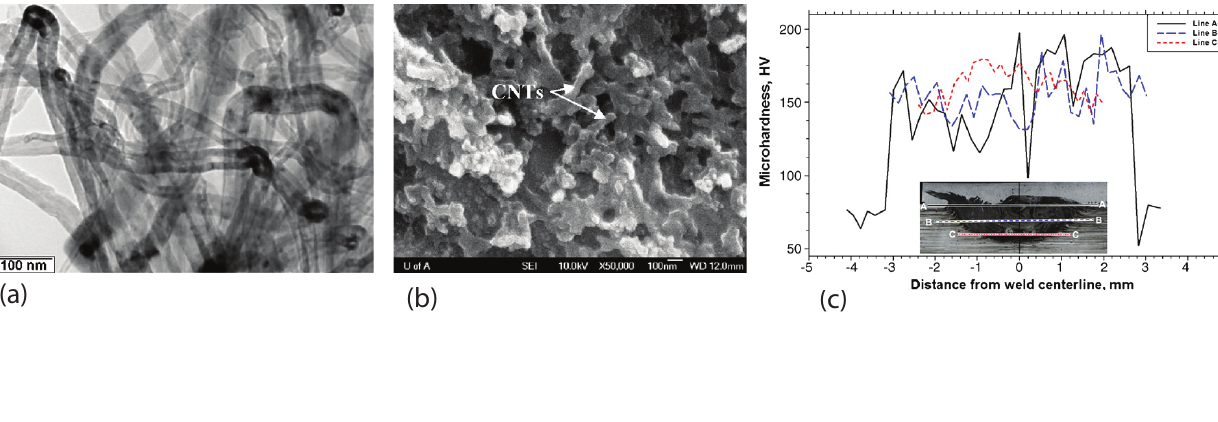
Figure 9 . Backscattered electron images showing friction stir processed in-situ particle reinforced composite materials: (a) the dispersion of fine Al in Al10Cu alloy (after Hsu et al. [63]); (b) uniformly distributed NiTi particles in the nugget region of FSP composite after annealing (after Dixit et al. [64]); (c) Al matrix (after Lee et al.